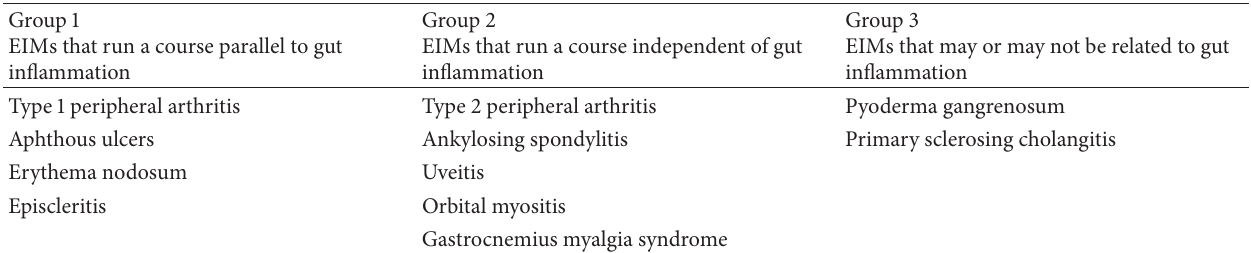
Table 1: Groups of extraintestinal manifestations by relationship to gut inflammation.